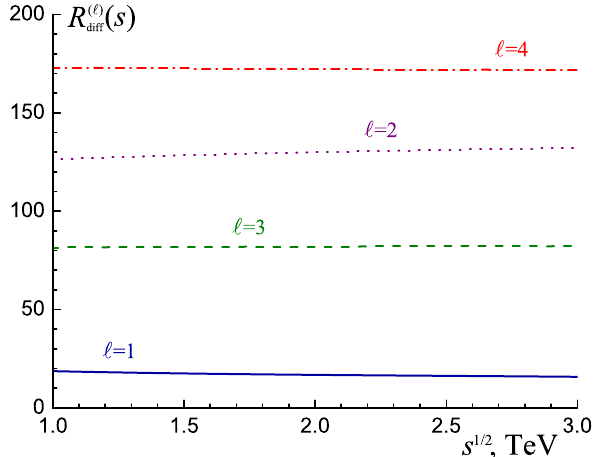
( s ) (86) in the energy range planned for the Fig. 8 The function R ((cid:11)) diff future CLIC experiment [4] at various loop